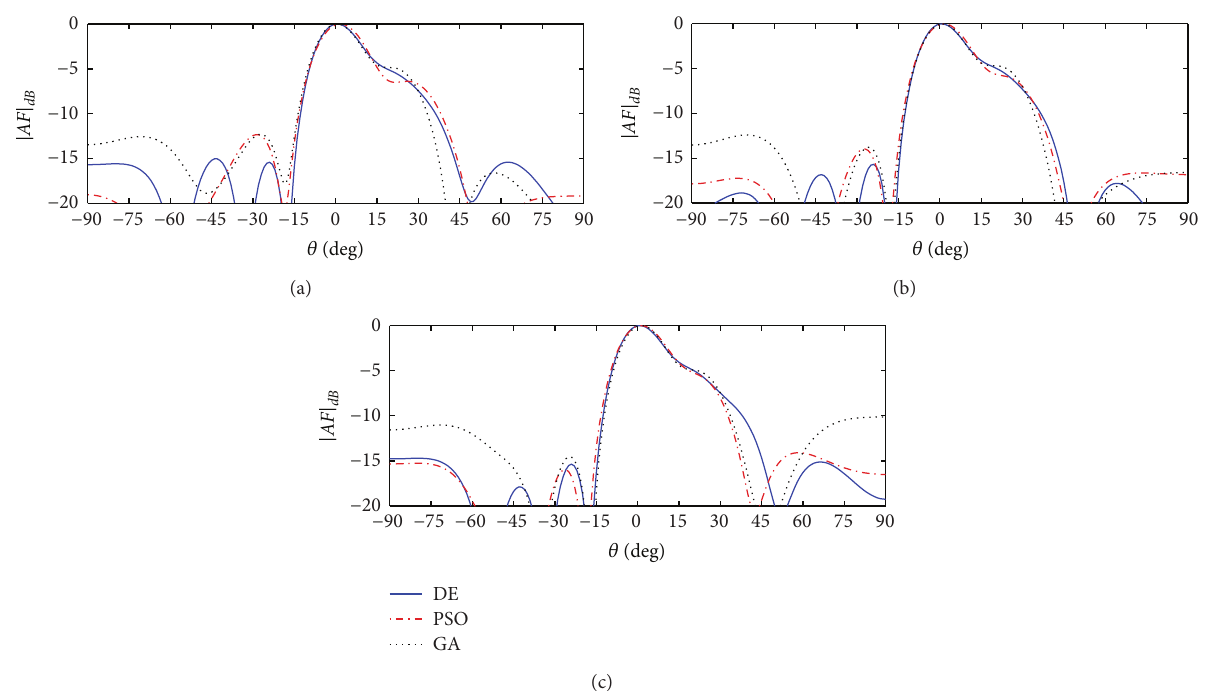
Figure 6: Optimized cosec 2 patterns from the concentric ring array: (a) for 𝜑 = 0 degree plane, (b) for 𝜑 = 5 degree plane, (c) for 𝜑 = 10 degree plane.